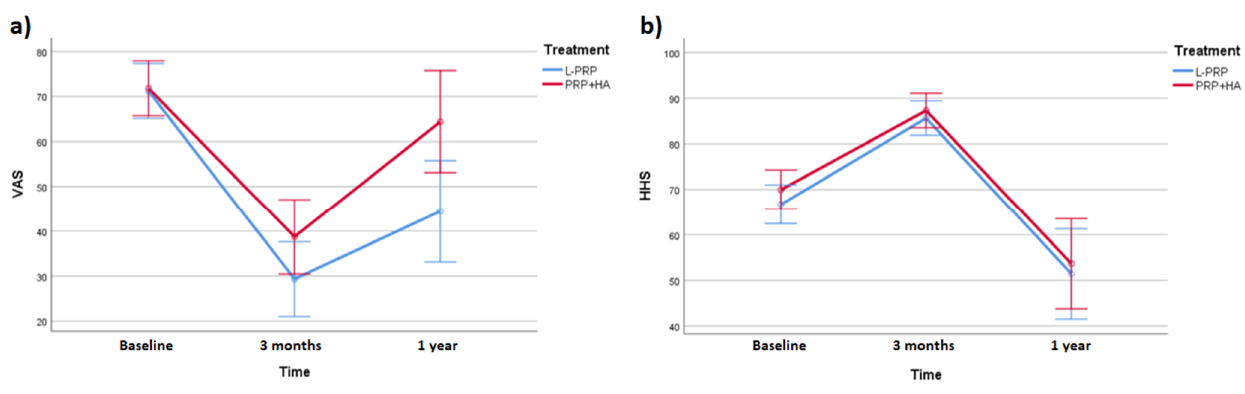
Figure 2. Profile plot of VAS and HHS at the different time points of the study in the two groups. Data are presented as estimated marginal means with 95% confidence interval. ( a ) shows a marked difference between average VAS score between the two groups. Difference is less evident ( b ). VAS = visual analog scale, HHS = Harris hip score.